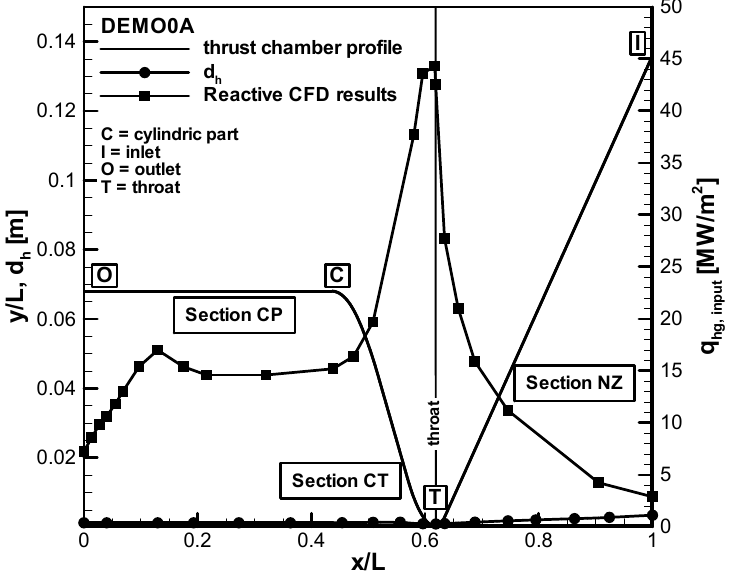
Figure 5. Chamber profile, hydraulic diameter of cooling channels and input heat-flux profile along the engine.